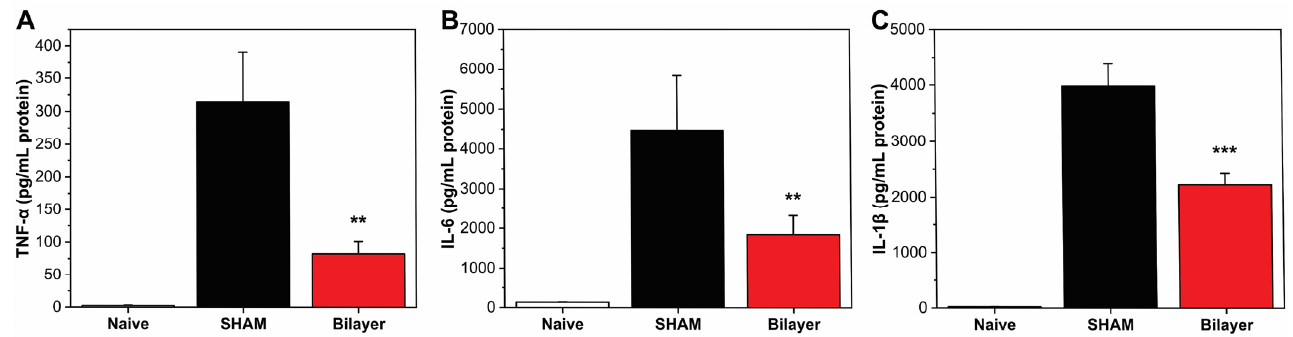
Figure 6. In vivo evaluation of IL-6 ( A ), IL-1 β ( B ), and TNF- α ( C ) levels in diabetic mice after 96 h from wound induction. ** p < 0.01, and *** p < 0.001, compared to untreated mice. from wound induction. ** p < 0.01, and *** p < 0.001, compared to untreated